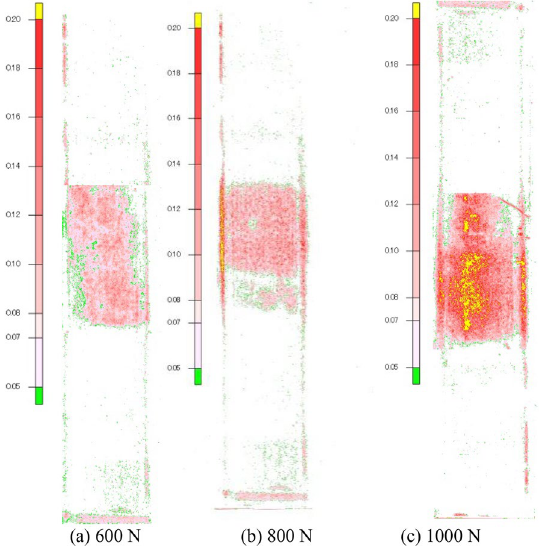
Figure 11 Experimental results of applying single concentrated force: a 600 N; b 800 N; c 1000